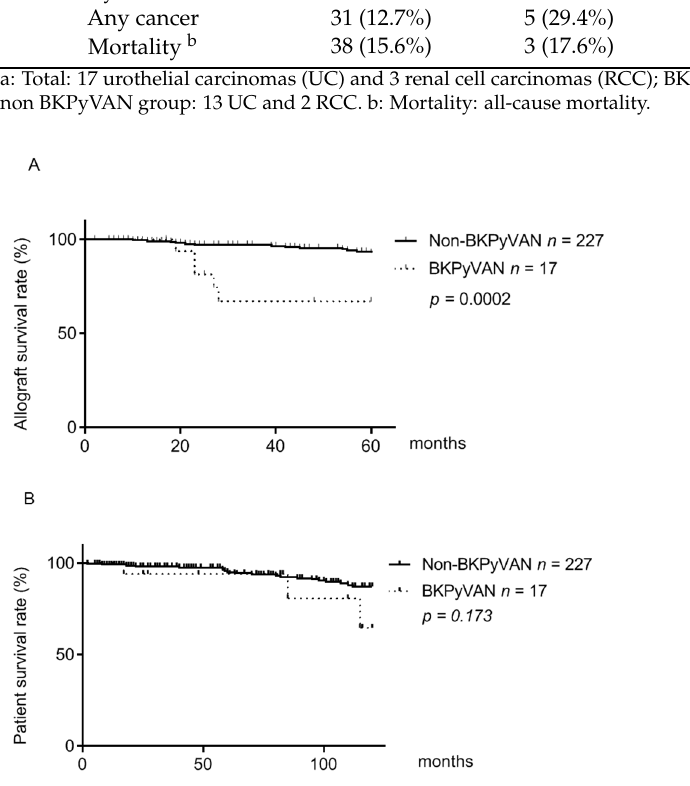
Table 2. Subtypes of cancers in kidney transplant recipients with/without BKPyVAN.